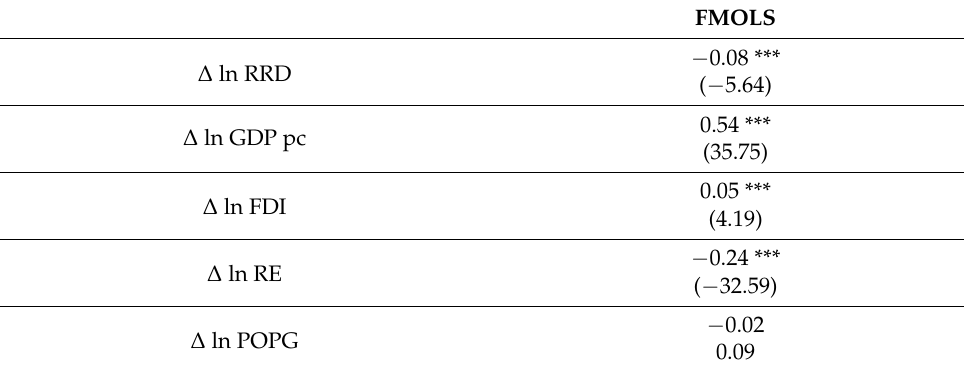
Table 5. Long-term